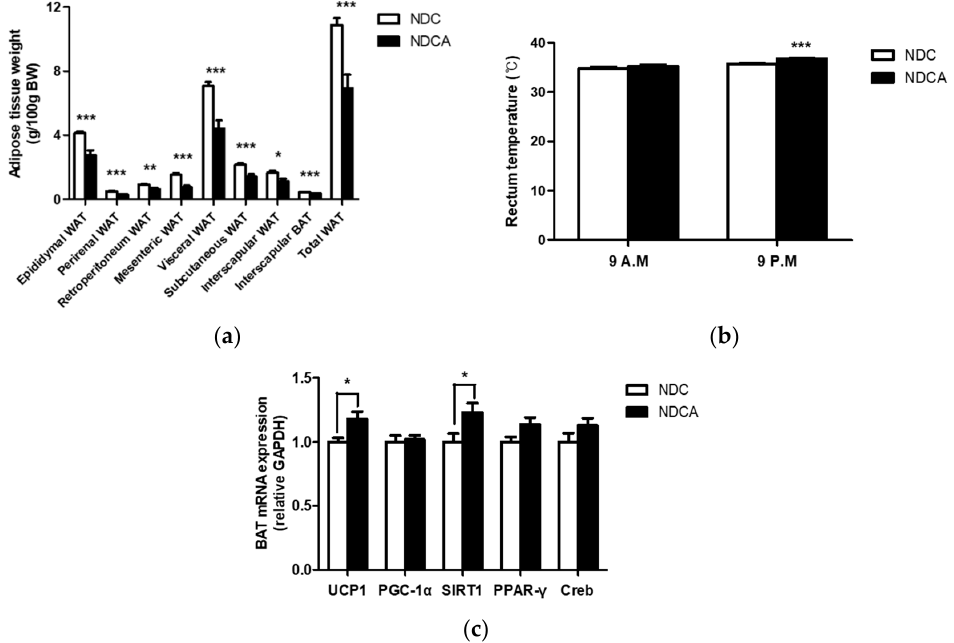
Figure 2. E ff ect of supplementation of a non-dairy creamer-enriched high-fat diet with D-allulose on adipose tissue weights, rectum temperature, and mRNA expression of genes related to thermogenesis factor in brown adipose tissue (BAT) of C57BL/6J mice fed the diet for 8 weeks: ( a ) adipose tissue weight; ( b ) rectum temperature; ( c ) BAT mRNA expression. Data are mean ± SE. Significant differences between the 5% D-allulose group and without D-allulose group are indicated; * p < 0.05, ** p < 0.01, *** p < 0.001. NDCA, high-fat diet with non-dairy creamer + 5% D-allulose; NDC, high-fat diet